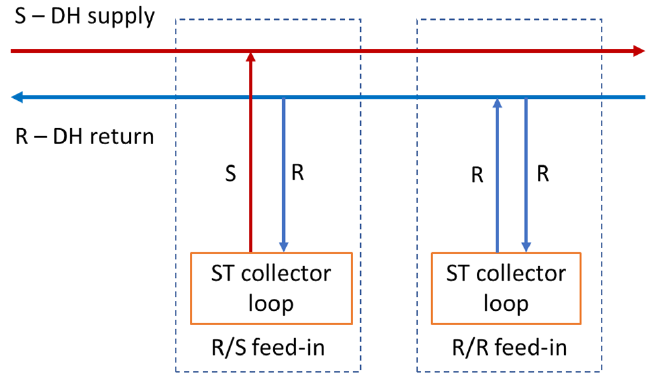
Figure 8. Two major feed-in principles for distributed solar DH systems.